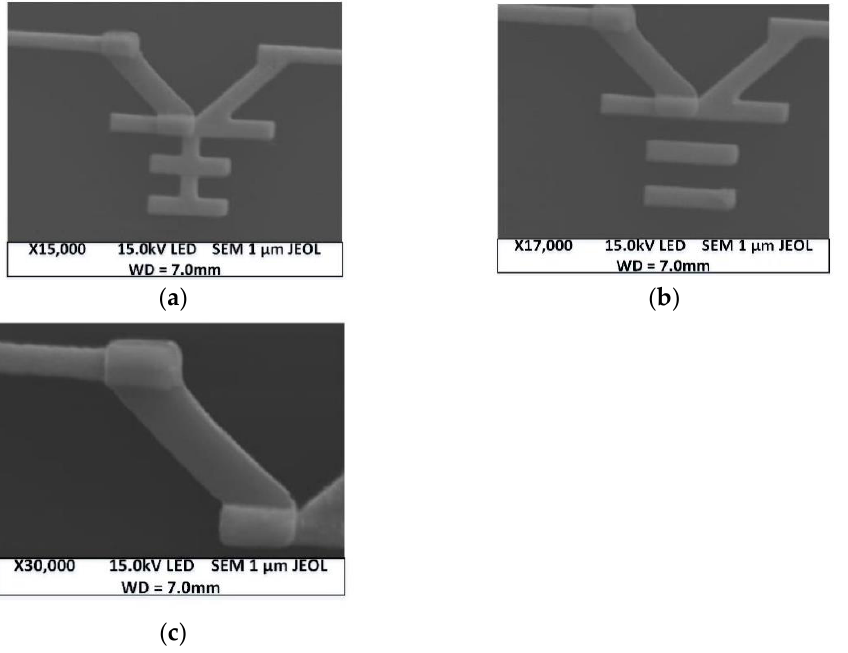
Figure 5. Obtained nanoantenna prototypes: ( a ) traditional Yagi–Uda; ( b ) quasi-Yagi–Uda; ( c ) nano-thermoelectric junction.